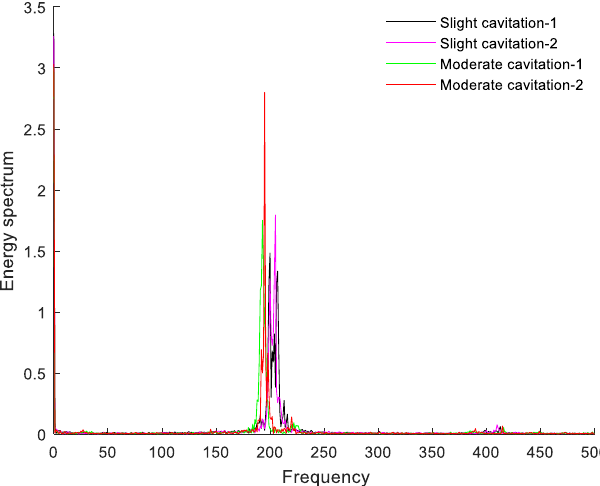
Figure 3. Energy spectrum of centrifugal pump vibration sensor signals.